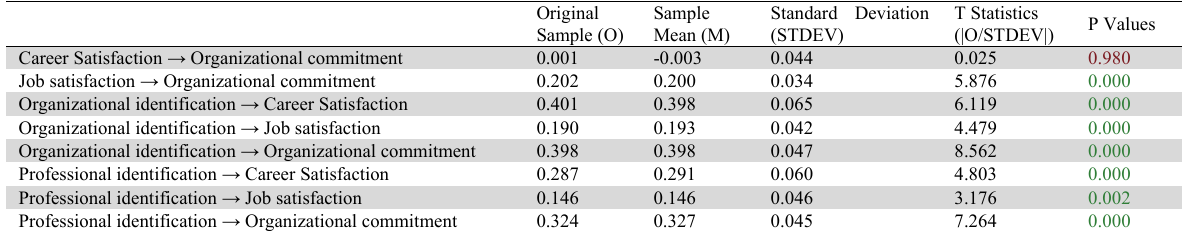
Path Coefficients